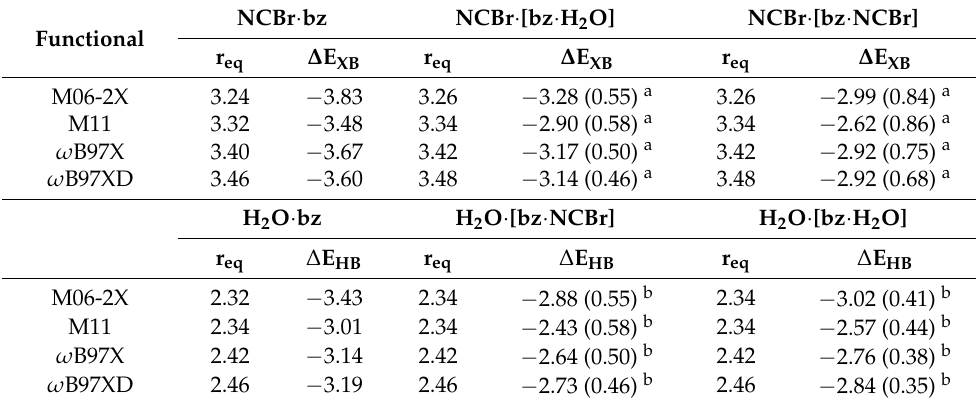
Figure 2. Binding energy curves, ∆ E, vs. (HO)H distance from the center of benzene ring, r, computed for ( a ) H 2 O · bz (blue line), ( b ) H 2 O · [bz · NCBr] (red line) and ( c ) H 2 O · [bz · H 2 O] (green line) systems in the T-shaped approach at the M06-2X/aug-cc-PVTZ level of theory. Table 1. Equilibrium distances r eq (Å) and interaction energies ∆ E XB and ∆ E HB (kcal/mol) for dimers and trimers in T-shaped and double T-shaped configurations,